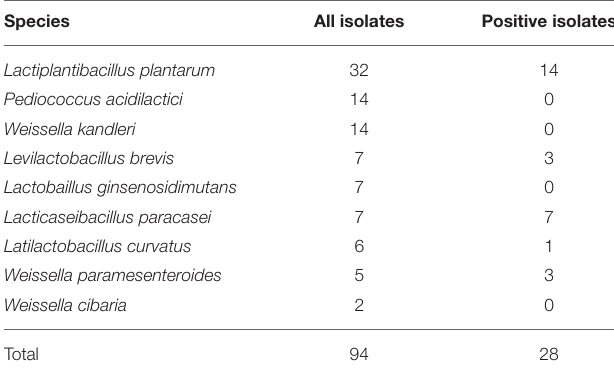
TABLE 1 | Lactic acid bacteria recovered from young rabbits and their inulin fermentation phenotype. Species All isolates Positive